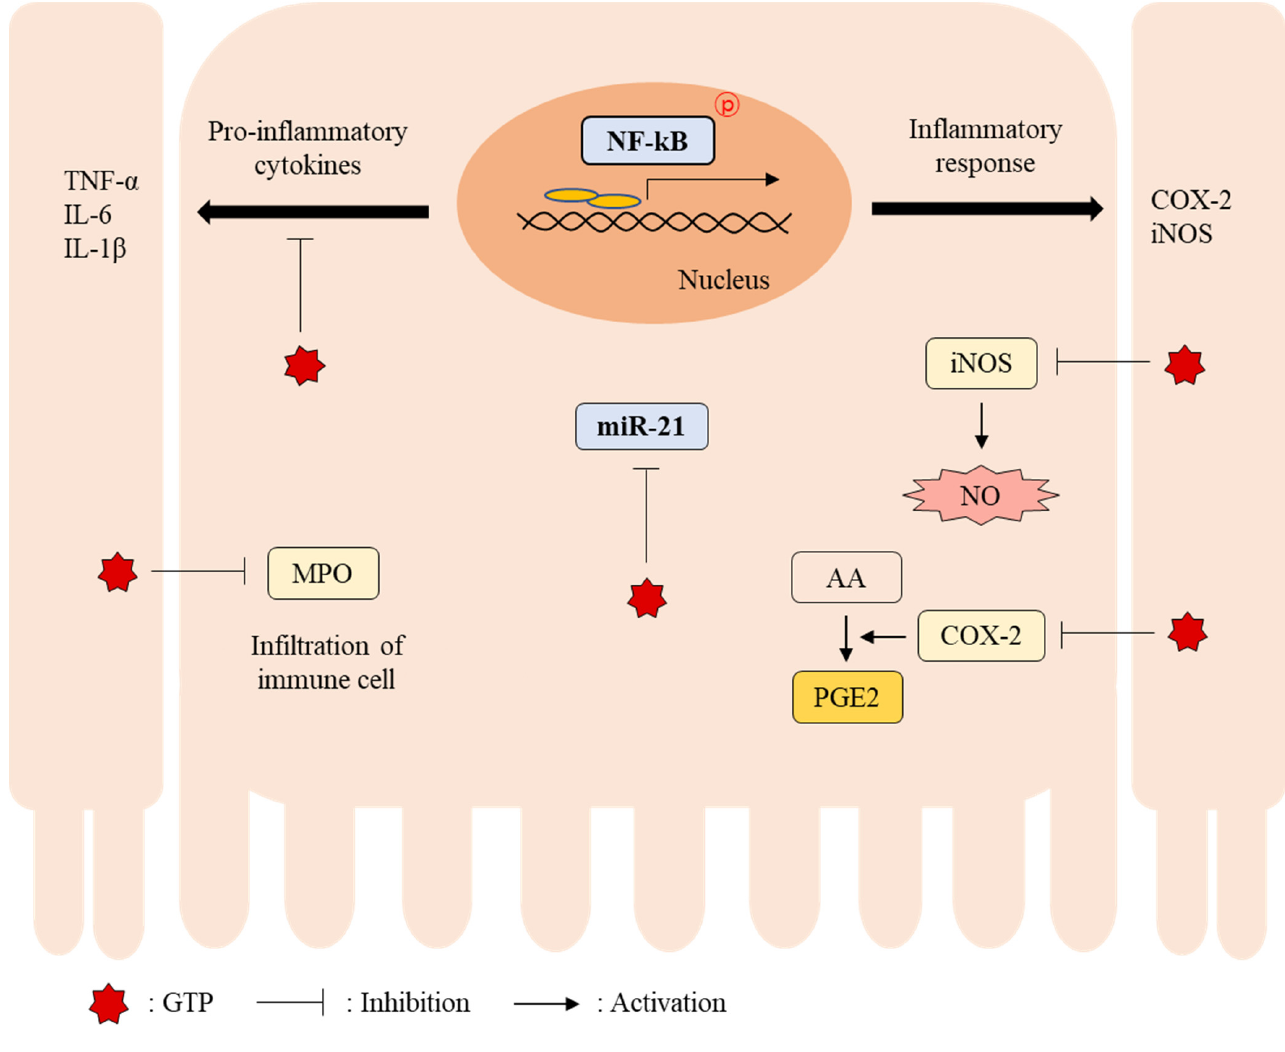
Figure 7. Schematic diagram of GTP-mediated regulatory mechanisms in the colon tissue of mice with DSS-induced colitis.; GTP, green tea extract containing Piper retrofractum fruit; DSS, dextran sulfate sodium; AA, arachidonic acid; COX-2, cyclooxygenase-2; IL-1 β , interleukin-1 β ; IL-6, interleukin 6; iNOS, inducible nitric oxide synthase; MPO, myeloperoxidase; miR-21, microRNA-21; NF- κ B, nuclear factor-kappa B; NO, nitric oxide; PGE2, prostaglandin E2; TNF- α , tumor necrosis factor ‐ alpha.